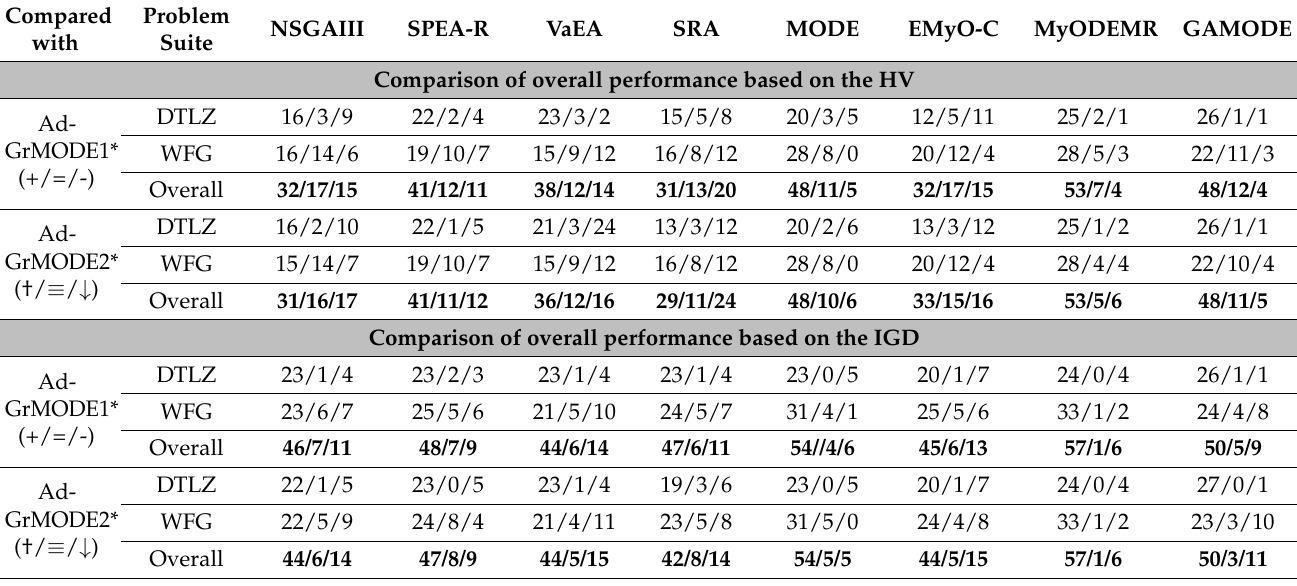
Table 4. Overall performance comparison of the proposed algorithm with state-of-the-art algorithms based on HV and IGD for DTLZ and WFG test